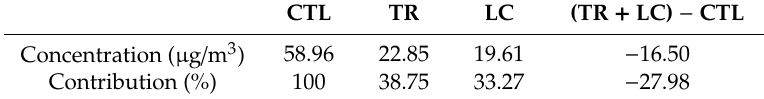
Table 4. Average concentration and contribution of PM 2.5 in PRD for di ff erent scenarios.